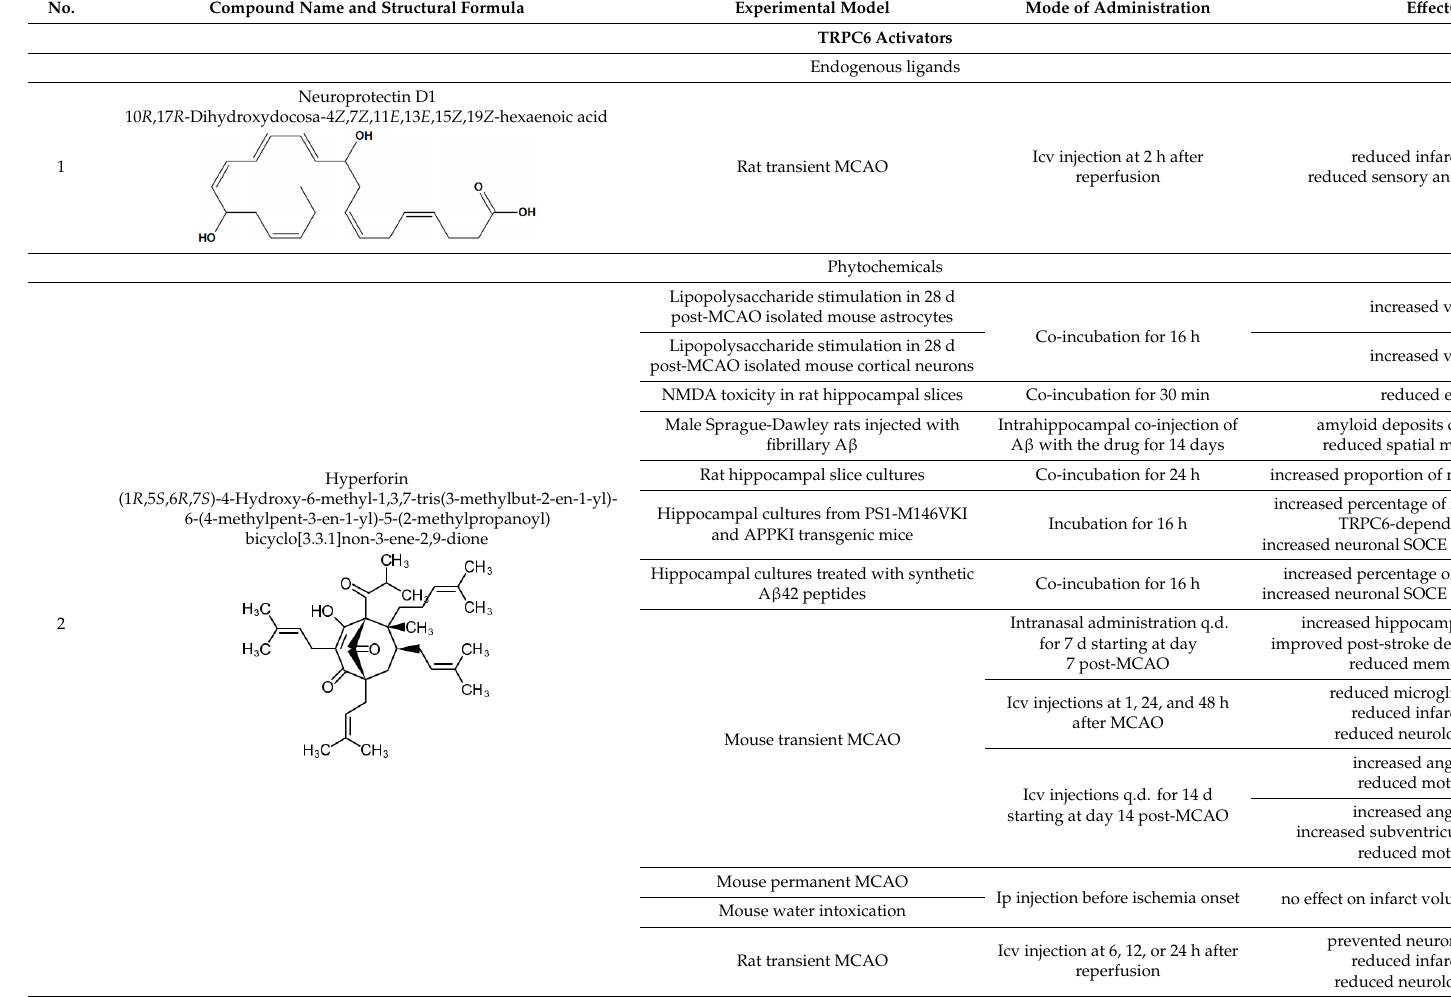
Table 1. Pharmacological modulators of TRPC6 in cerebral ischemia and AD models.